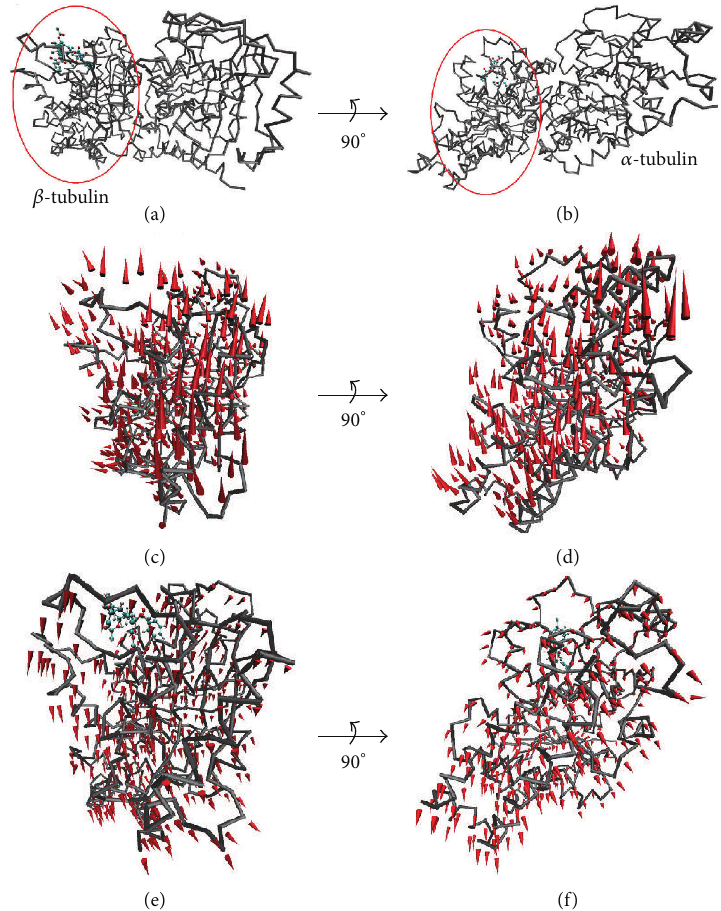
Figure 9: Comparative analysis of motion modes for the 𝛽 -tubulin and docked complex1 systems. ((a)-(b)) The structures of 𝛼𝛽 -tubulin and the 𝛽 -tubulin subunit are marked with red oval. ((c)-(d)) The L713283-unbound 𝛽 -tubulin system. ((e)-(f)) The complex1 system. The motion mode is shown with cone model, in which the length is correlative with motion magnitude and the arrow corresponds to motion direction. Protein backbone is represented with C 𝛼 stick model in gray, while small molecule L713283 is shown with ball-and-stick